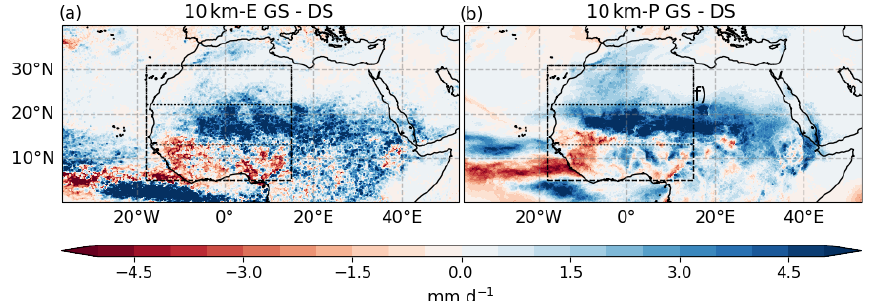
Figure B5. JAS mean difference in precipitation rate between the GS and DS simulation for the 10km-E (a) and the 10km-P (b) experiment, respectively. The dashed box indicates the WA analysis domain.